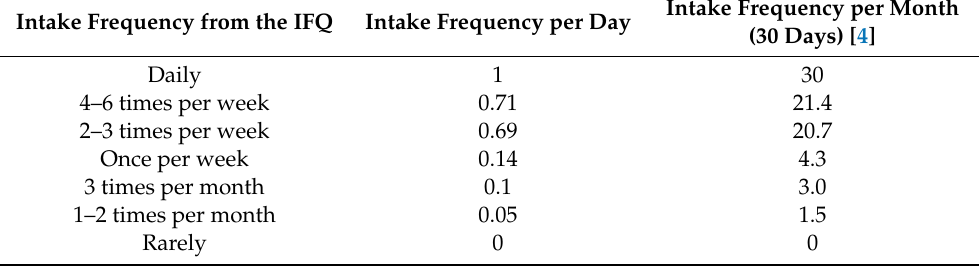
Table 2. Categories of intake frequency